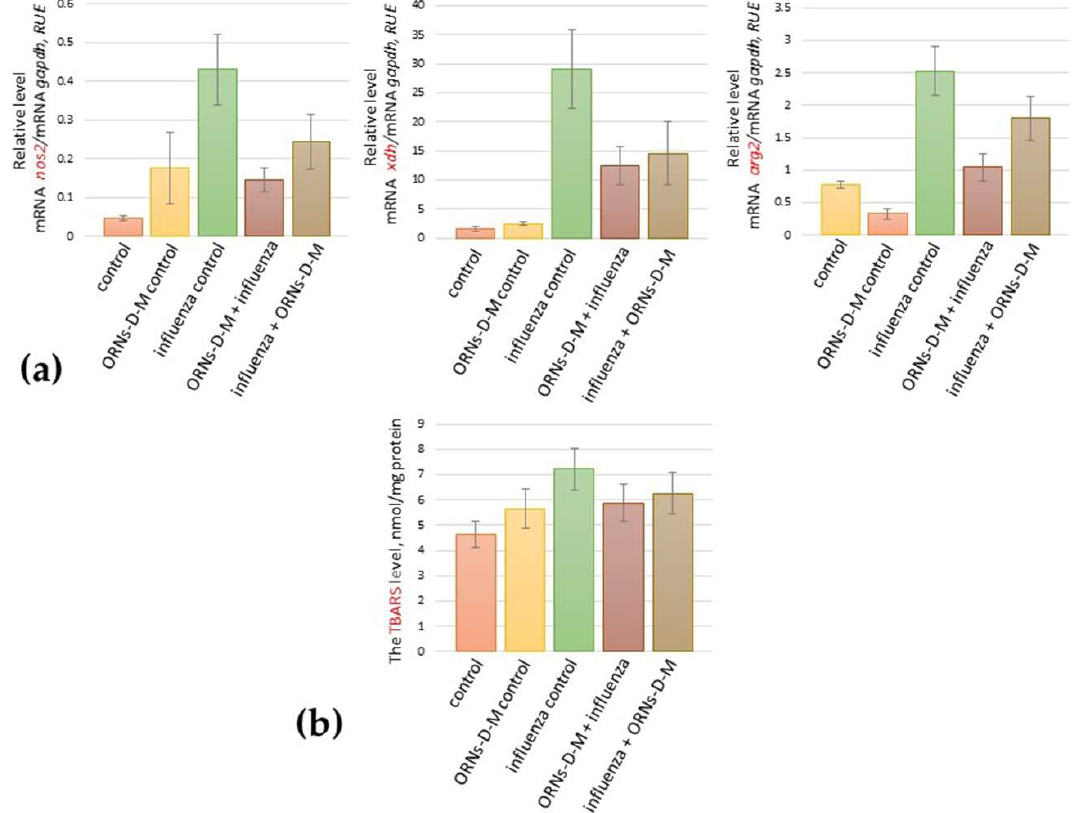
Figure 1. ( a ) Impair the up-regulation of nos2 , arg2 , and xdh induced by the influenza virus A/Fort Monmouth/1/1947-mouse adapted (H1N1) and ( b ) decrease the LPO products at the influenza virus infection owing to the ORNs- D -М in vivo. Before and after infection with the influenza virus FM147 (4.0 lg LD 50 ), the BALB/c mice were treated with the ORNs- D -М. Total RNAs from the mice lungs were isolated and RT-qPCR was performed. The investigated mRNA levels were normalized to gapdh as a control. The TBARS level was tested as described by Asakawa and Matsushita. RUE: relative units of expression. ORNs- D -М control—ORNs- D -М injection into healthy mice, influenza control—infection of mice with the influenza virus, ORNs- D -М + influenza—ORNs- D -М injection 24 h before influenza virus infection as a form of prevention with ORNs- D -М, and influenza + ORNs- D -М—ORNs- D -М injection 24 h after influenza virus infection as treatment with ORNs-D-М. Data are shown as the mean ± SD for three independent experiments.